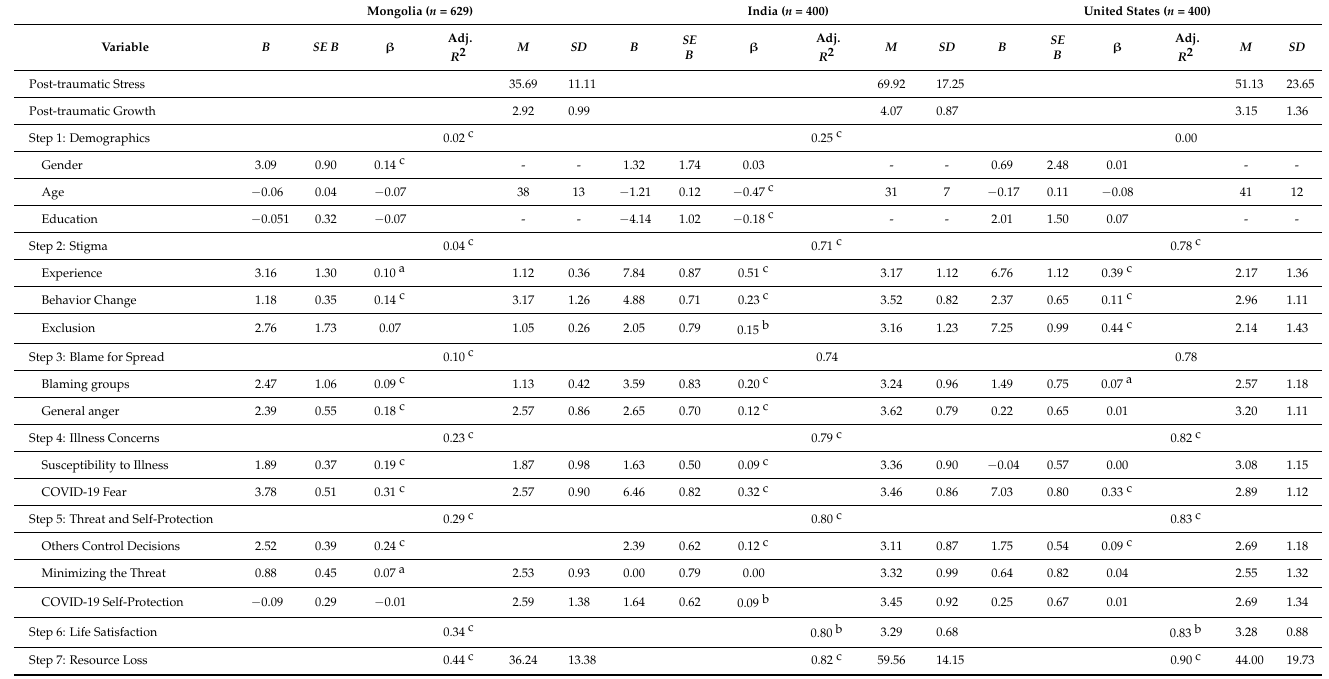
Table 1. Predicting post-traumatic stress during the COVID-19 pandemic in Mongolia, India, and the United States. Mongolia( n =629) India( n =400) UnitedStates( n